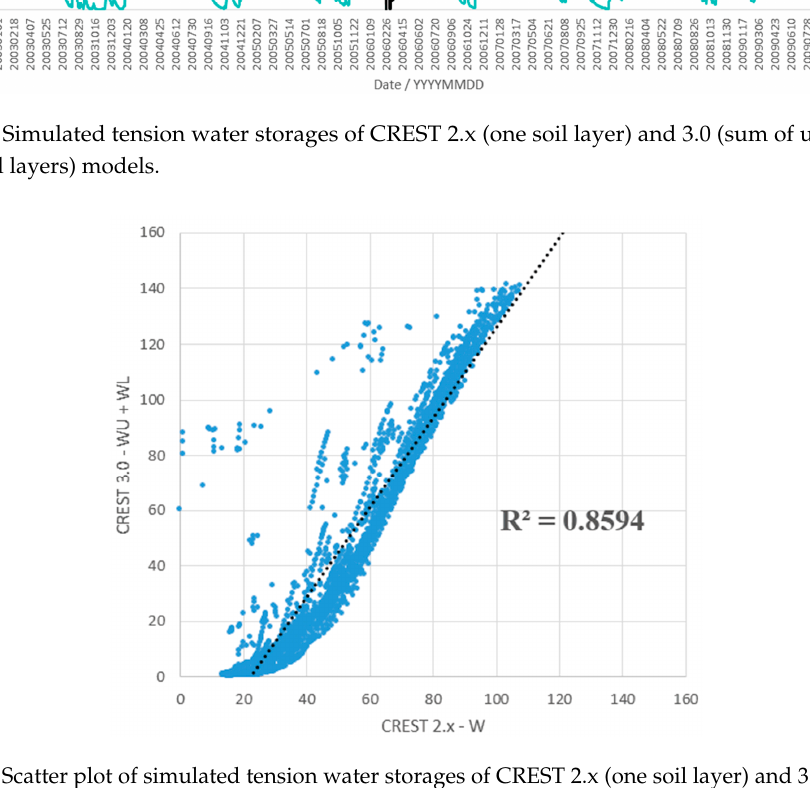
Figure 7. Scatter plot of simulated tension water storages of CREST 2.x (one soil layer) and 3.0 (sum of upper and lower soil layers) models.